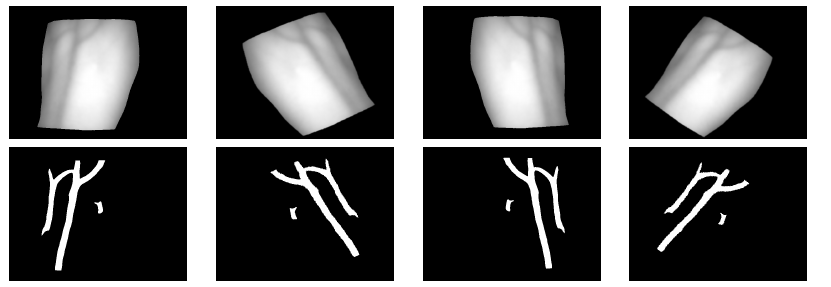
Figure 12. Different augmented images of the original image ( first column ), augmented images ( first row ) and corresponding labels ( second row ).